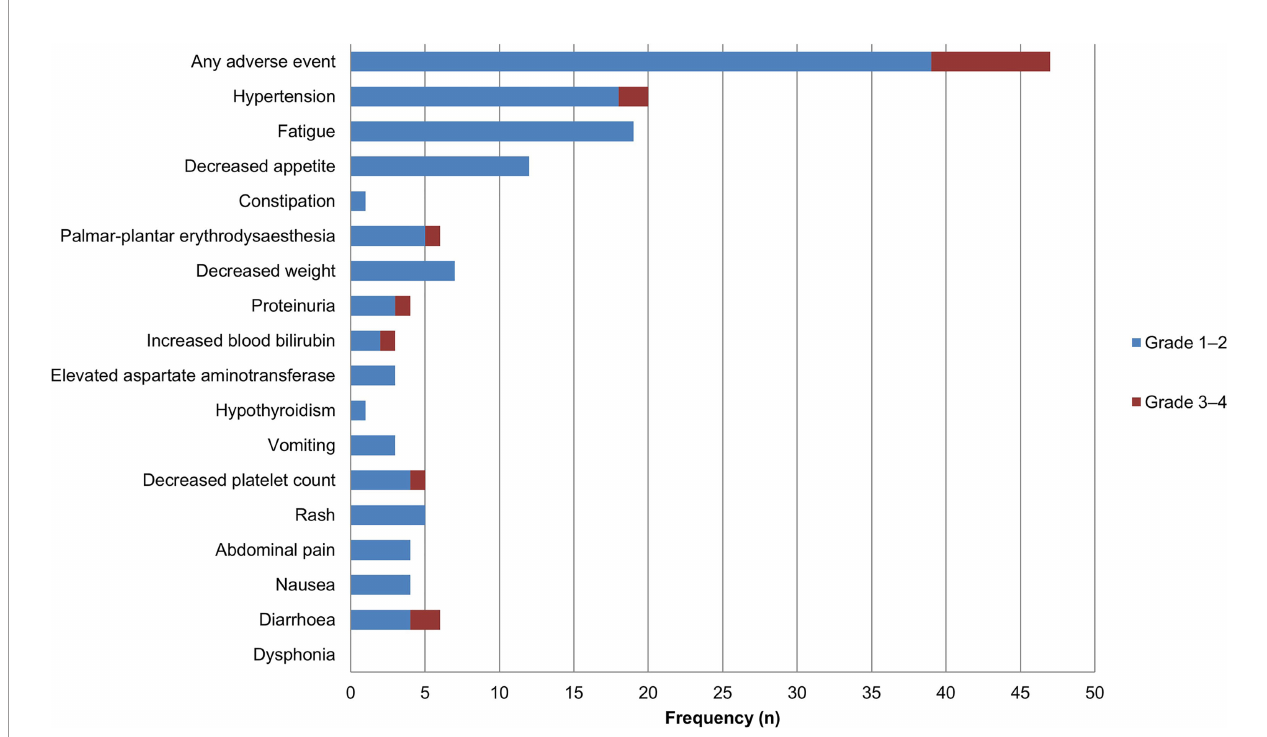
FIGURE 3 | Adverse events during lenvatinib treatment in patients with biliary tract carcinoma (n = 41). Grade 1 – 2 adverse events are represented in blue, and grade 3 – 4 adverse events are represented in